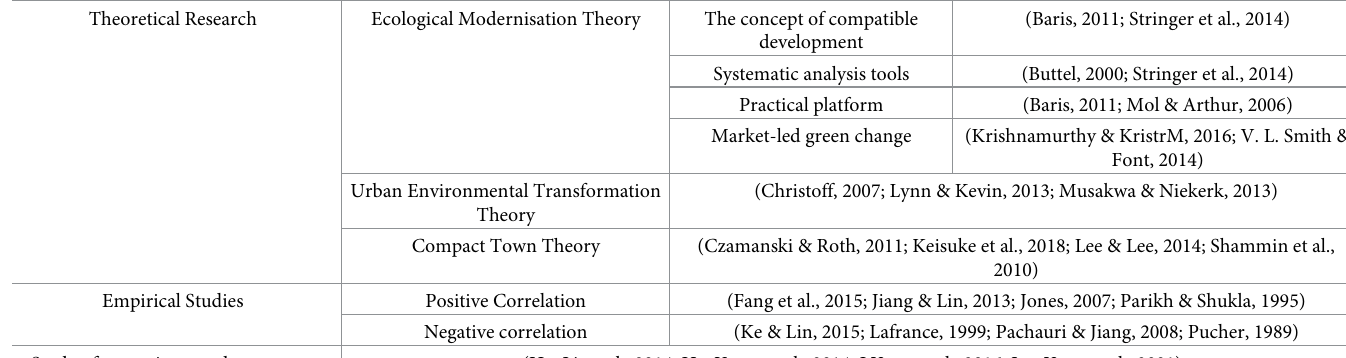
Table 1. Summary of the